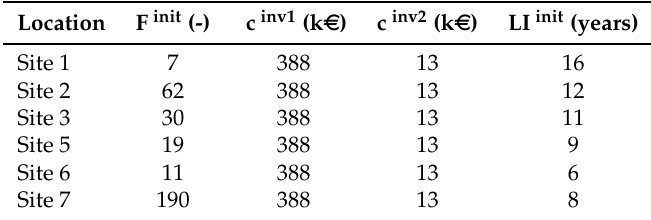
Table 1. Existing boilers and their investment